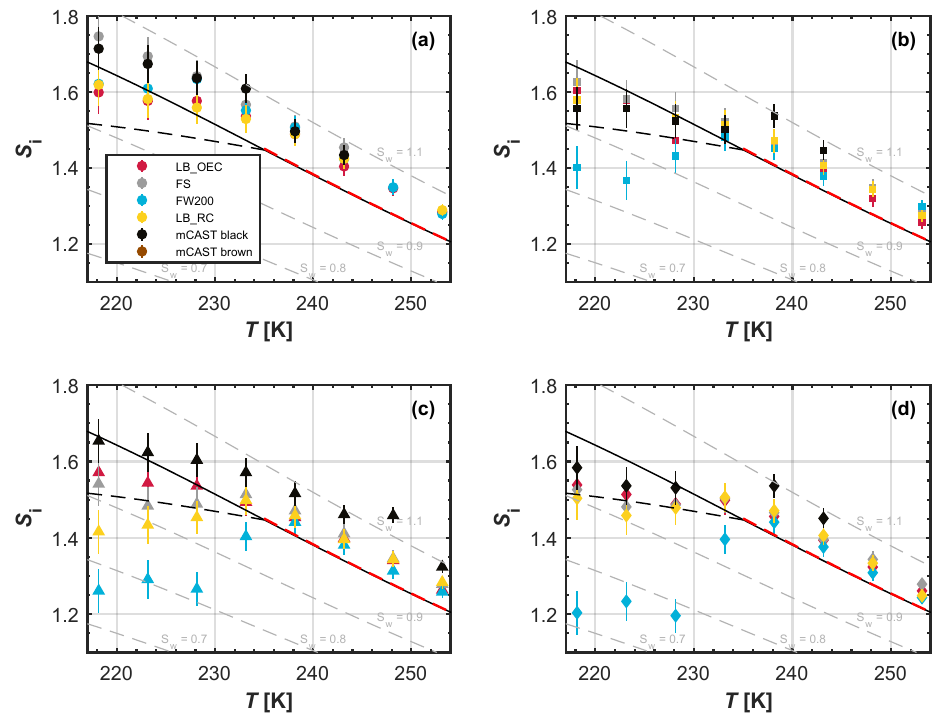
Figure 2. Onset saturation ratio with respect to ice ( S i ) of freezing where 1% of the aerosol particles are activated as a function of temperature for size-selected particles with mobility diameter of (a) 100, (b) 200, (c) 300 and (d) 400nm (see Supplement Sect. S6). The black, solid lines denote water saturation using the water saturation pressure parameterization given by Murphy and Koop (2005); gray, dashed lines indicate offsets from this line in steps of 0 . 1 to guide the eye. The black, dashed lines mark the homogeneous freezing threshold for supercooled solution droplets according to Koop et al. (2000). The red, dashed line indicates WDS conditions. WDS appears close to water saturation for the 1µm OPC channel used. Each dot represents the mean of a minimum of two RH scans performed with HINC. Temperature uncertainty is 0 . 1K and S i uncertainties, outlined in Appendix D1, are indicated as vertical bars. We note that mCAST black and brown do not activate to 1% and are thus not plotted for some conditions (see Supplement Sect. S2 for complete AF